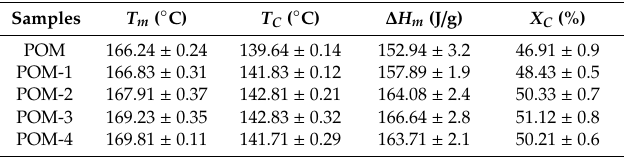
Table 2. Di ff erential scanning calorimetry (DSC) parameters of POM / Ag nanocomposites at the heating / cooling rate of 10 ◦ C /